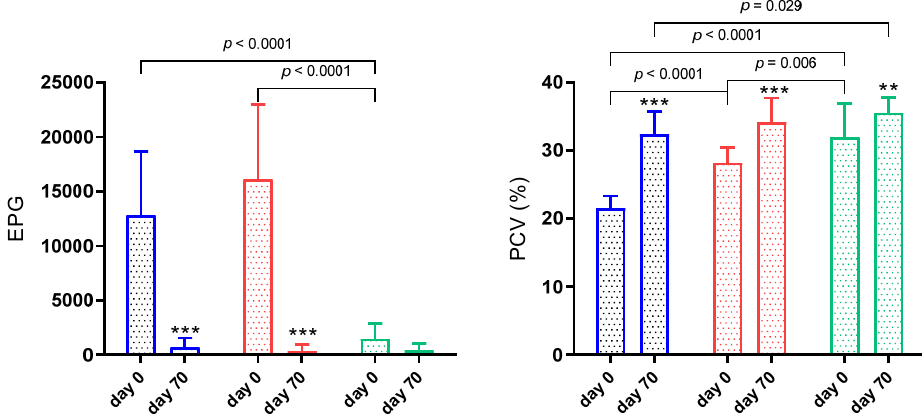
Figure 1. Faecal worm egg counts (EPG) and packed cell volume (PCV) in sheep naturally infected by gastrointestinal nematodes included in an integrated crop-livestock (ICL) system for 70 days. G1 (blue bar): EPG higher than 5000 and PCV lower than 24%; G2 (red bar): EPG higher than 5000 and PCV higher than 24%; G3 (green bar): EPG lower than 5000 and PCV higher than 24%. Asterisks indicate significantly different from day 0. ** p < 0.01; *** p < 0.001.